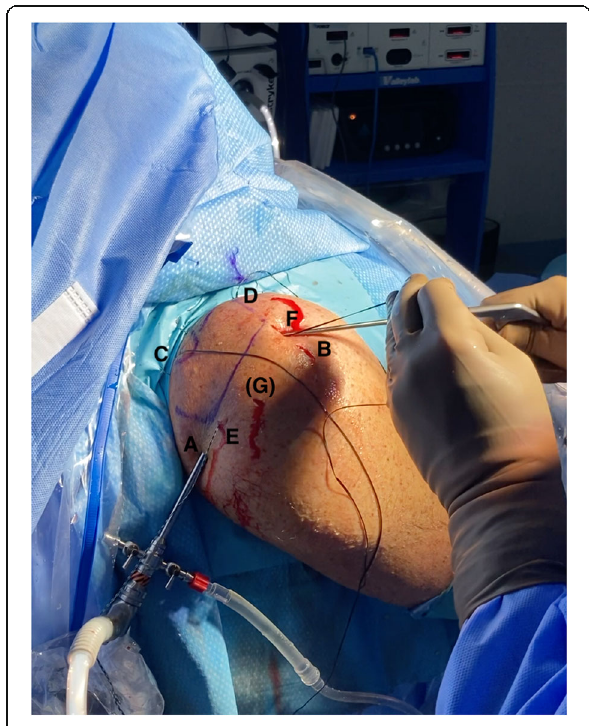
Fig. 3 Cannula-free arthroscopic portals and 4 milimetric incisions for tapes passage. Right shoulder, patient in beach-chair position. A: standard posterior viewing portal; B: lateral portal for working and graft passage; C: incision for posteromedial tape / Neviasier; D: incision for anteromedial tape; E: incision for posterolateral tape; F: incision for anterolateral tape; (G): accessory lateral portal may be necessary for better viewing when handling